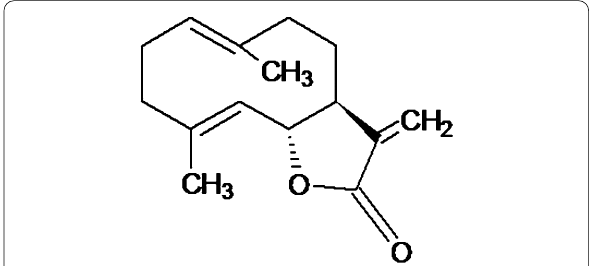
Fig. 1 Chemical structure of costunolide (Rasul et al. 2012) as the target secondary